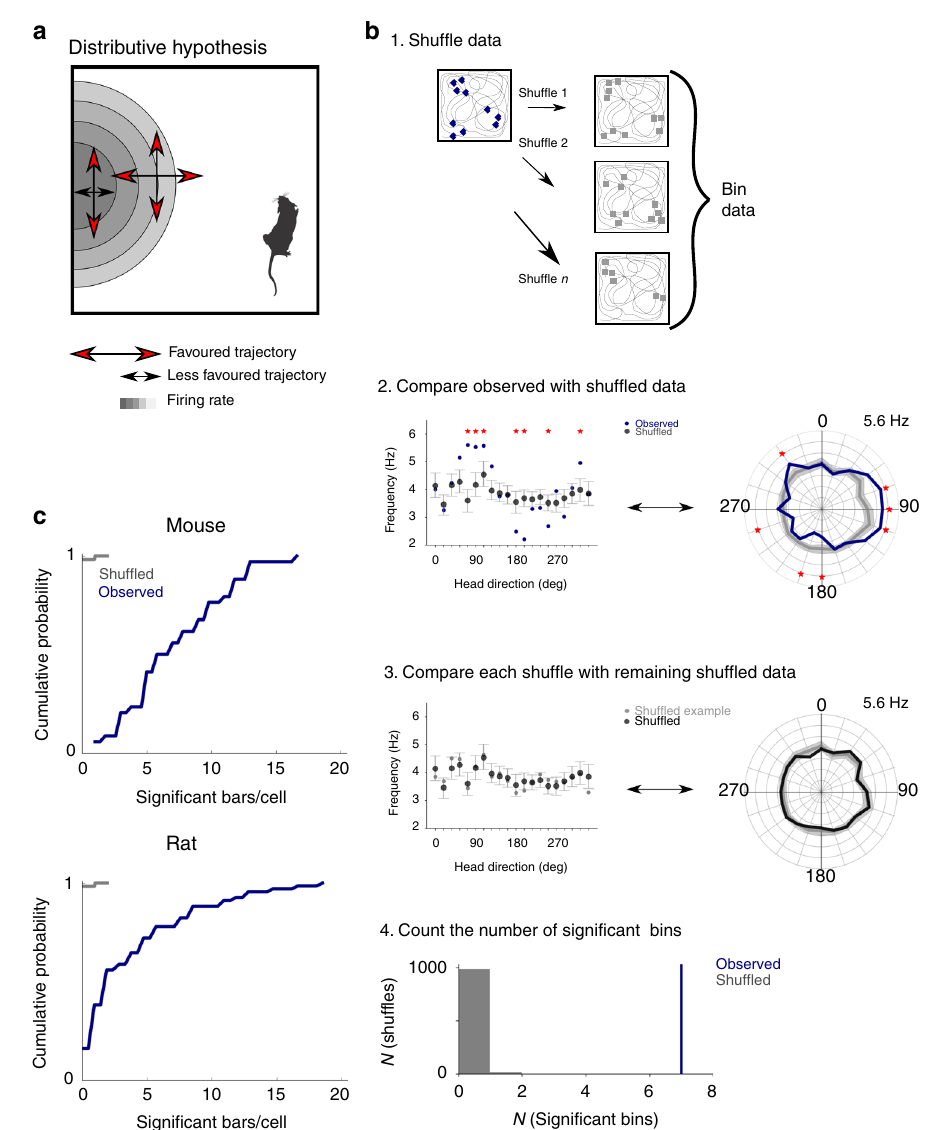
Fig. 2 The distributive hypothesis does not account for directional modulation. a Schematic of directional tuning caused by behavioural bias that can be explained by the distributive hypothesis 18 . Red arrows indicate head directions likely to be more sampled relative to the directions indicated by the black arrows. Differences in sampling directions at the centre and edge of the fi eld can lead to an apparent directional bias (Mouse schematic from scidraw.io (https://doi.org/10.5281/zenodo.3910057, https://creativecommons.org/licenses/by/4.0/). b (1) Shuf fl ed spike locations were generated by allocating spikes to the trajectory according to probabilities determined by the spatial fi ring rate map. Circles represent recorded spikes and squares represent shuf fl ed spikes. (2) Observed and shuf fl ed spike rates binned by head direction (bin width 18°, distributive plot) and visualized either with Cartesian (left) or polar coordinates (right). Error bars/shaded areas indicate the 90% con fi dence intervals of the shuf fl ed data and the measure of centre is the mean. Asterisks indicate bins in which the observed data differs signi fi cantly from the shuf fl ed data ( p < 0.05, two-tailed p value calculated from the shuf fl ed distribution and corrected for multiple comparisons with the Benjamini – Hochberg procedure). (3) As for step 2 but comparing individual shuf fl es to the overall shuf fl ed distribution. (4) The number of signi fi cant bins in the observed data (determined as in step 2) and the shuf fl ed data (determined by repeating step 3 for all shuf fl es). The example data are from the cell in Fig. 1b. c The distributions of the number of signi fi cant bins per cell differed signi fi cantly between observed and shuf fl ed data ( n = 34 grid cells from mice, p = 6.5 × 10 − 24 , U = 10.08; n = 68 grid cells from rats, p = 2.4 × 10 − 29 , U = 11.25, two-sided Mann – Whitney U Inspection of individual fi elds from the same cell suggests that their directional modulation differs from one another (Fig. 3c).